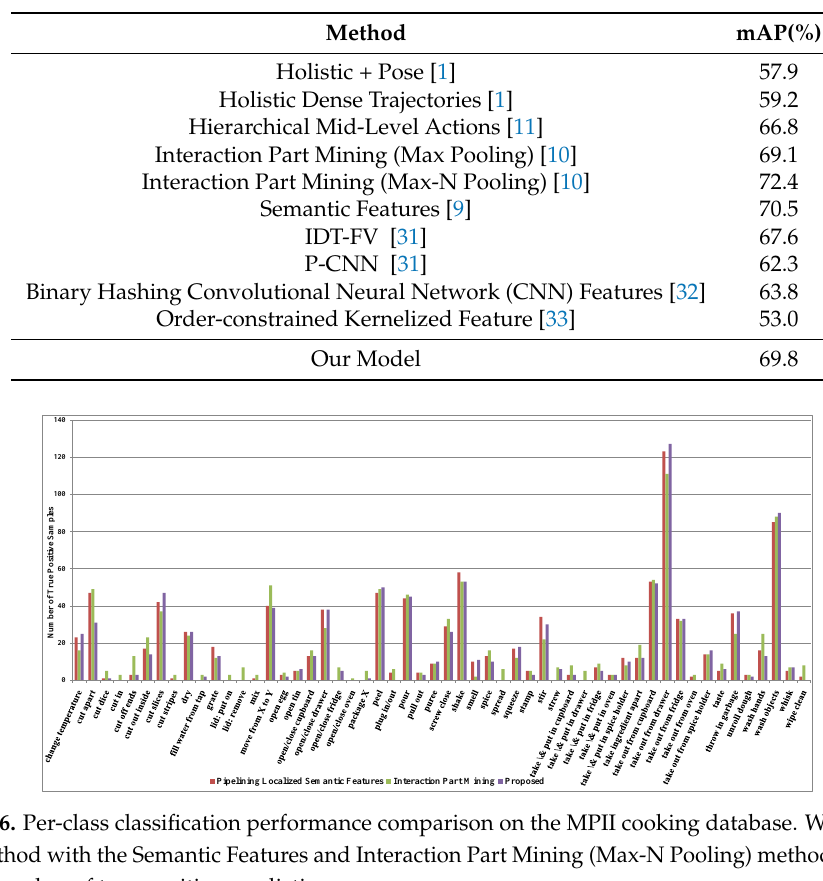
Table 4. Comparison of action recognition accuracies of different methods on the MPII cooking database.